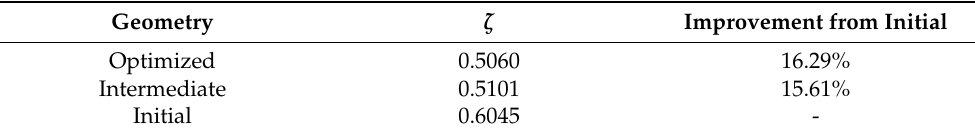
Figure 16. Circumferential distribution of the flow angle 𝛽 for different positions in initial (dashed line) and optimized (solid line) geometries. Table 5. Flow loss